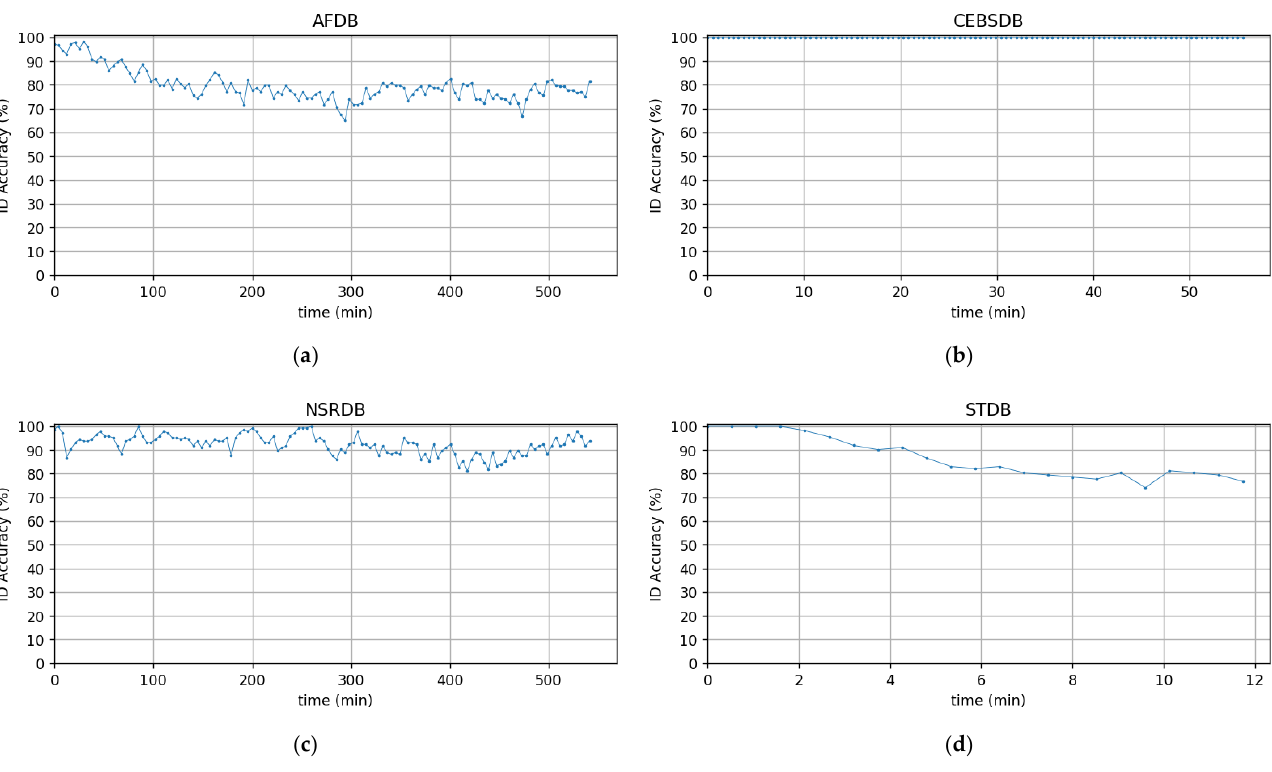
Figure A11. Closed identification accuracy is plotted against time separation for: ( a ) AFDB, ( b ) CEBSDB, ( c ) NSRDB, ( d ) STDB.